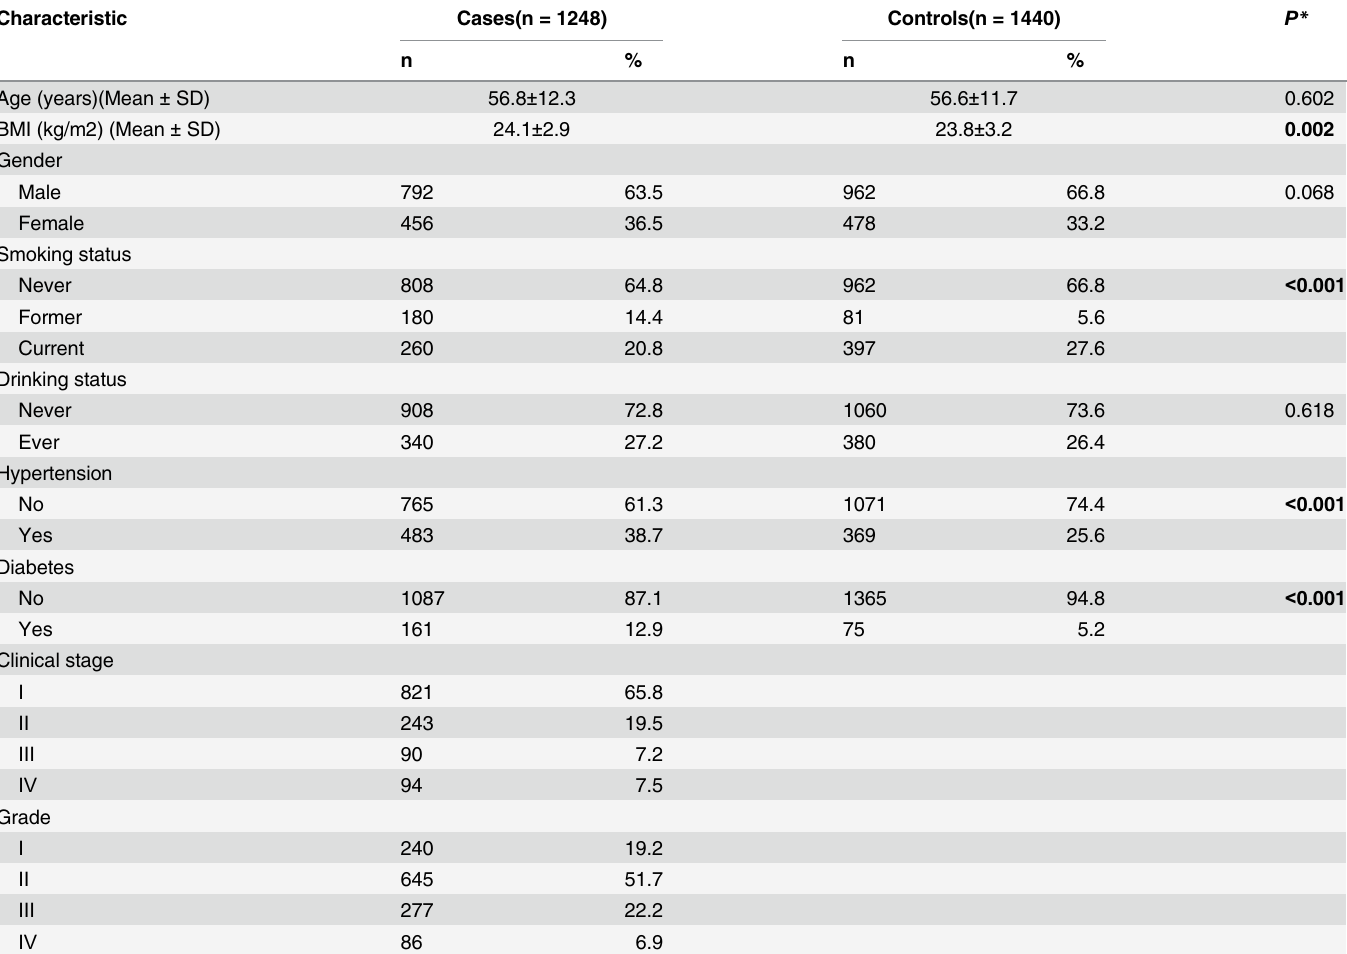
Table 1. Distribution of selected characteristics among the ccRCC cases and control subjects. Characteristic